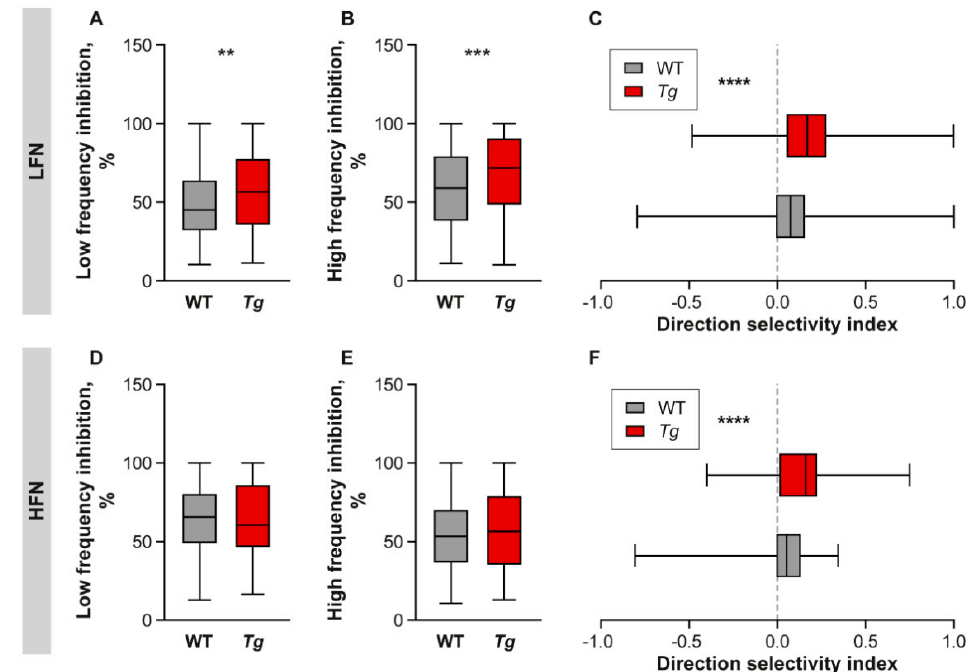
Figure 7. Two-tone inhibition and FM direction selectivity. ( A , B , D , E ) Comparison of low- ( A , D ) and high-frequency ( B , E ) sideband inhibition strength in LFN ( A , B ) and HFN ( D , E ) in WT and Tg IC. Median with interquartile range and extremes, Mann-Whitney test, ** p < 0.01, *** <0.001. ( C , F ) Fre- quency modulated stimulus direction selectivity of LFN ( C ) and HFN ( F ). Median with interquartile range and extremes, Mann-Whitney test **** p < 0.0001. HFN: high frequency neurons, LFN: low frequency